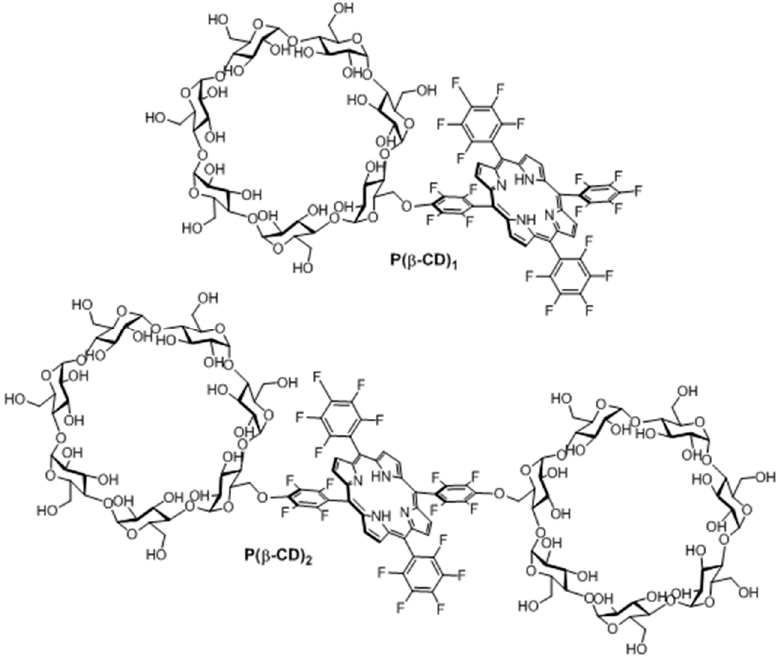
Figure 18. Chemical structure of P( β -CD) 1 and P( β -CD) 2 .